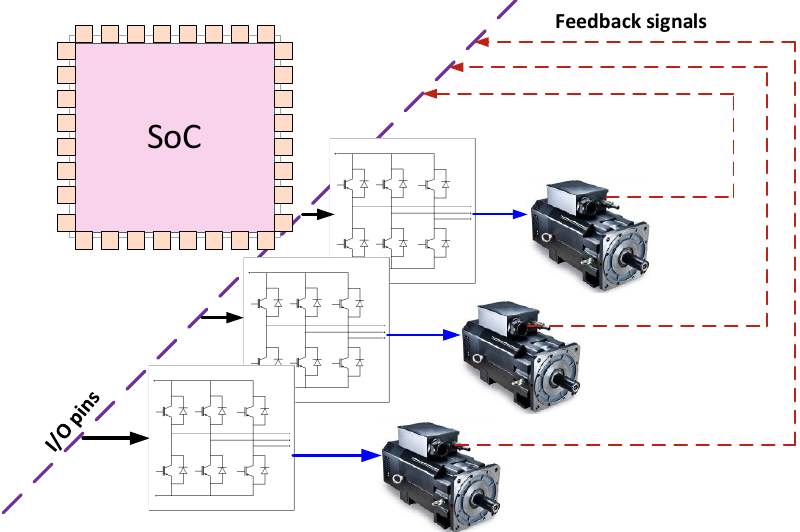
Figure 1. Multi-axis servo control system with universal SoC embedded in coprocessor as main control chip.